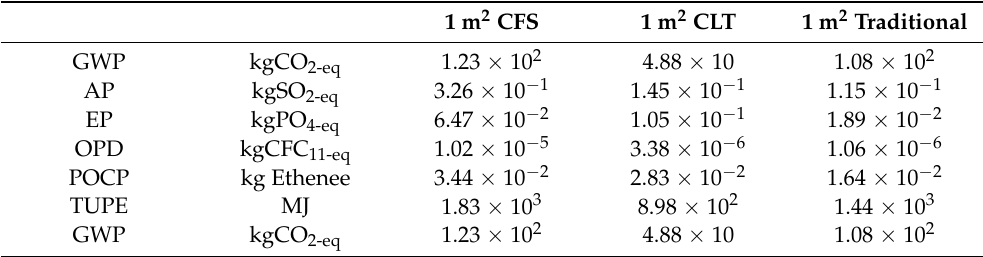
Table 17. LCA results: external